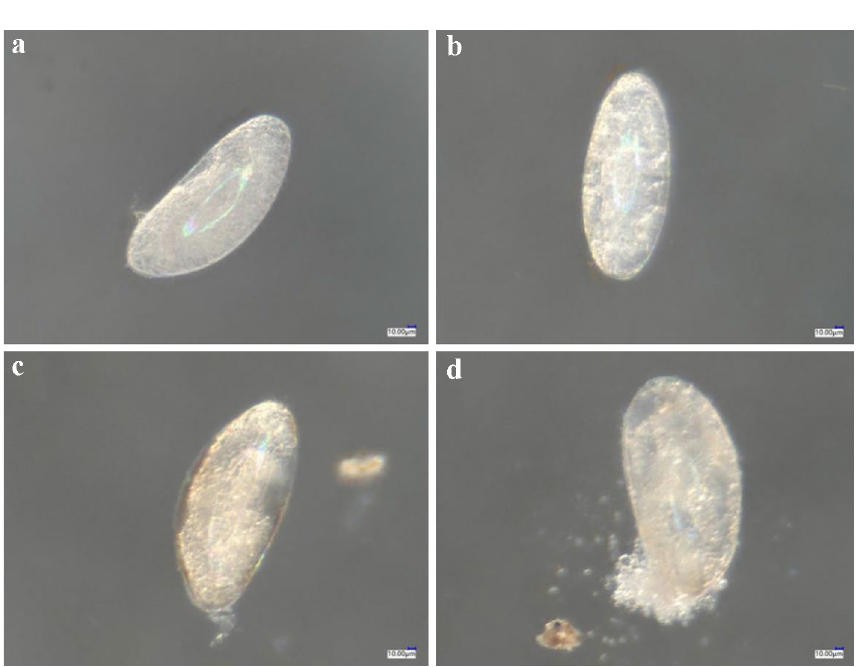
Figure 11. Effects of spirotetramat on development of 0-h-old eggs of F. occidentalis. ( a ) Frankliniella occidentalis initial eggs; ( b ) eggs developing 12 h after spirotetramat treatment; ( c ) eggs developing 24 h after spirotetramat treatment; ( d ) eggs developing 36 h after spirotetramat